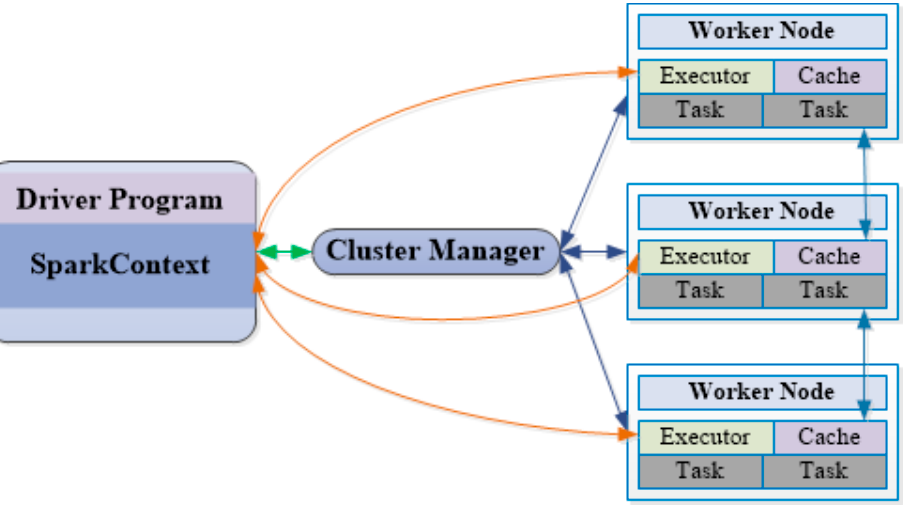
Figure 2. Working mechanism of a Spark Application on a Cluster.